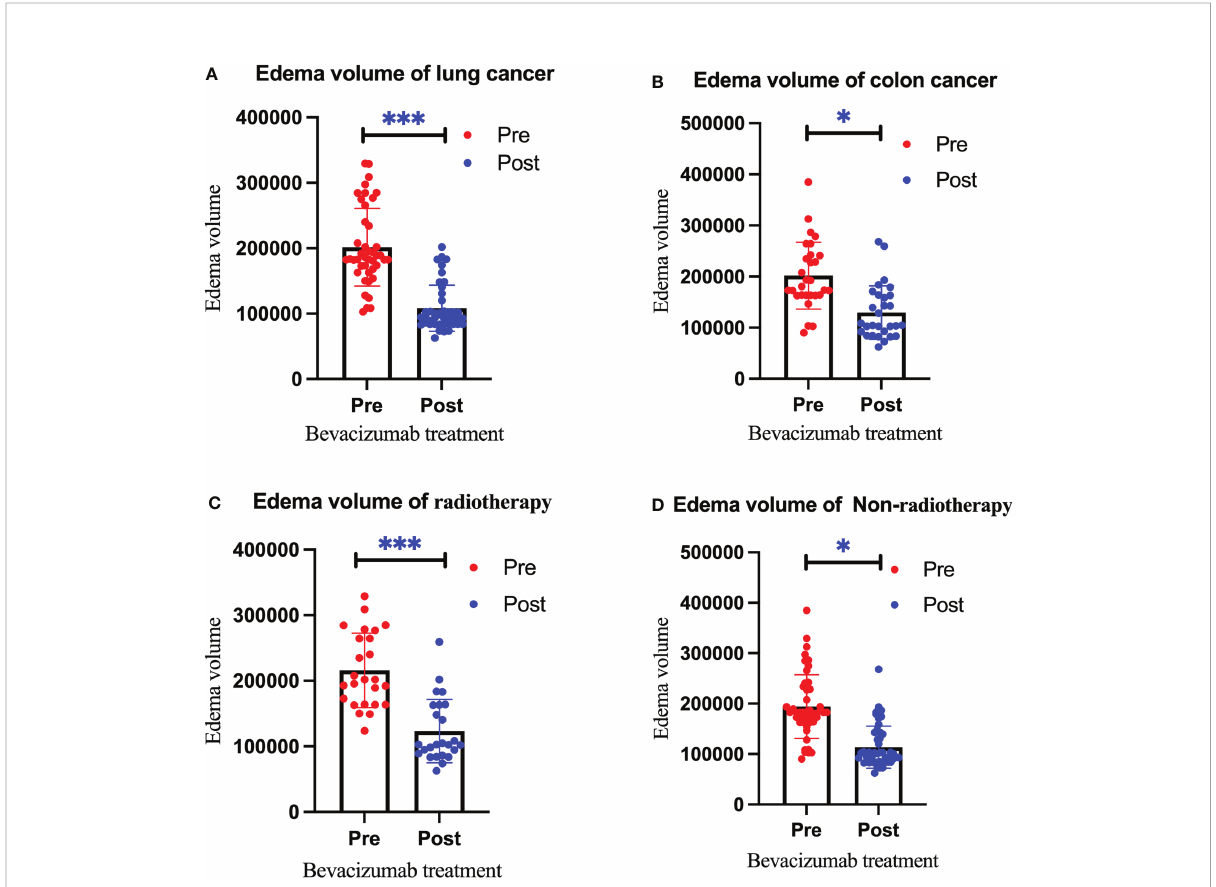
FIGURE 2 Changes in the edema volume before and after bevacizumab treatment in the lung cancer group (A) , colon cancer group (B) , radiotherapy group (C) , and non-radiotherapy group (D) . Red represents the edema volume before treatment, and blue represents the edema volume after treatment. We use * to indicate statistical difference. * for p<0.05, and *** for p<0.001.